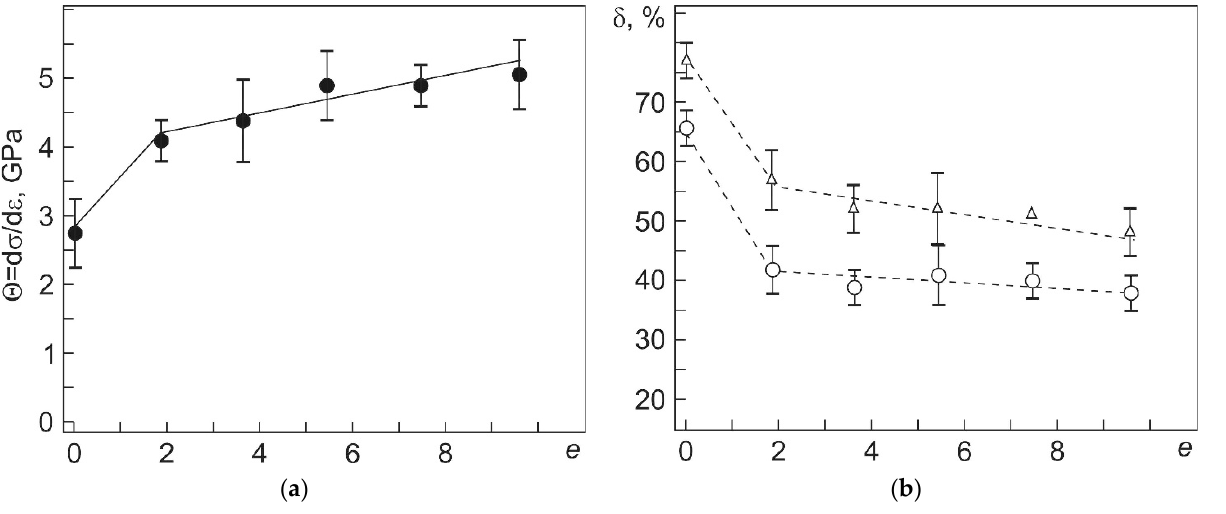
Figure 7. The strain-hardening coefficient ( ● ) at the quasi-liner stage of deformation of the samples ( a ) and the values of elongation to the ultimate tensile strength, ( ο ), and to the failure of the samples, ( Δ ), ( b ) as the function of the true strain.